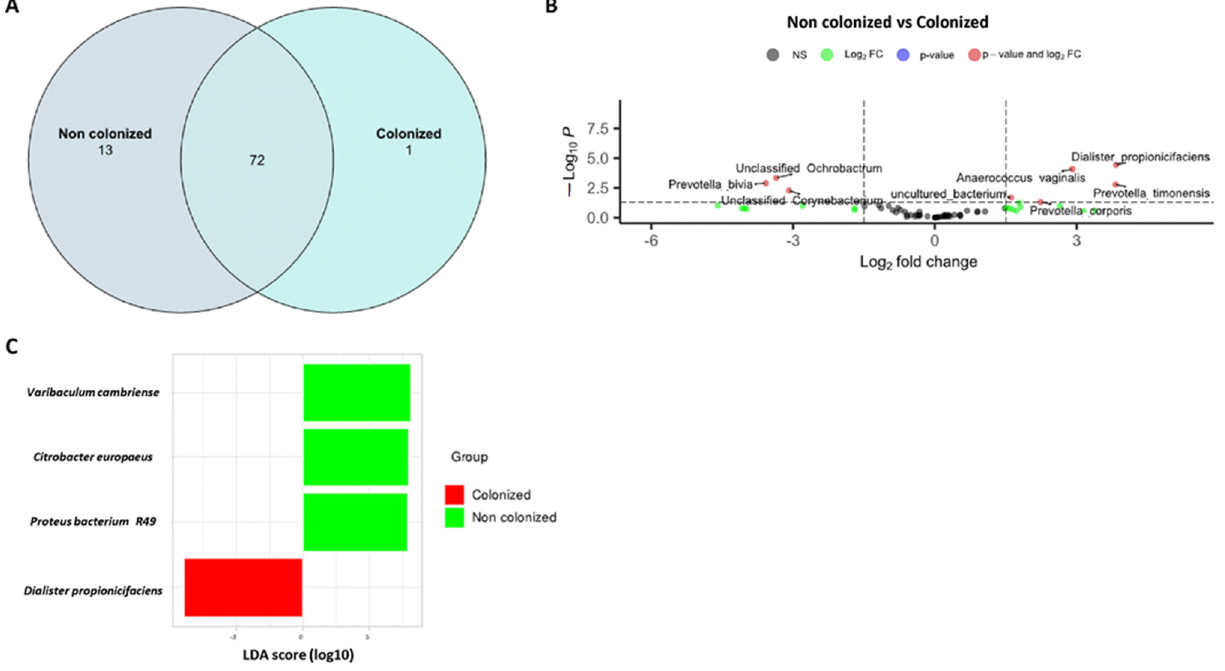
Figure 3. Non-colonized and colonized groups presented differential abundance in some taxa at genus level that could be used as possible biomarkers for predicting colonization. ( A ) Venn diagram showing ASVs distribution between non-colonized and colonized groups (detection level = 0.001 and prevalence = 0.75). ( B ) Volcano plot showing differential abundance taxa of colonized samples vs. non-colonized samples. ( C ) Linear Discriminant Analysis (LDA) Effect Size (LEfSe) plot of taxonomic biomarkers ( p value = 0.05 and LDA value = 2).